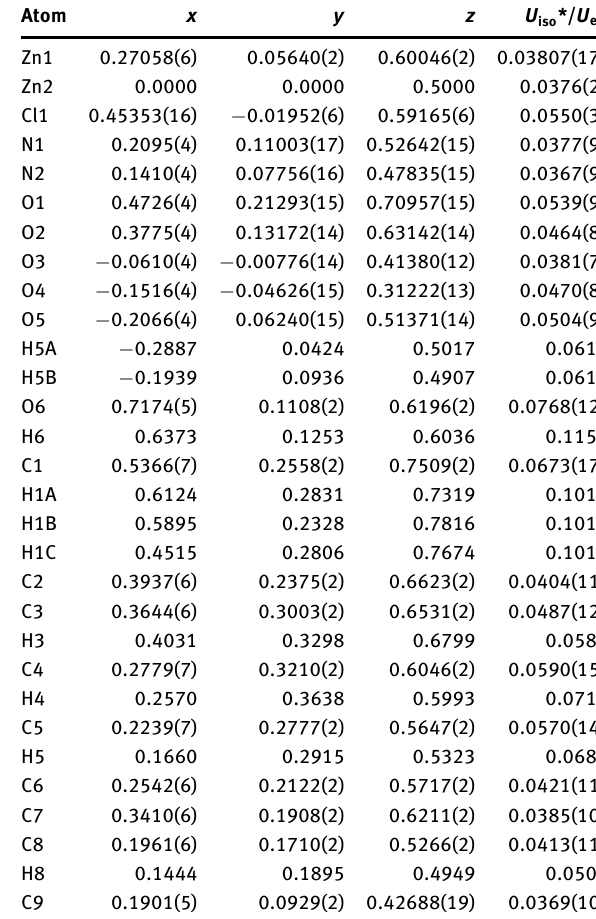
Table 2: Fractional atomic coordinates and isotropic or equivalent isotropic displacement parameters (Å 2